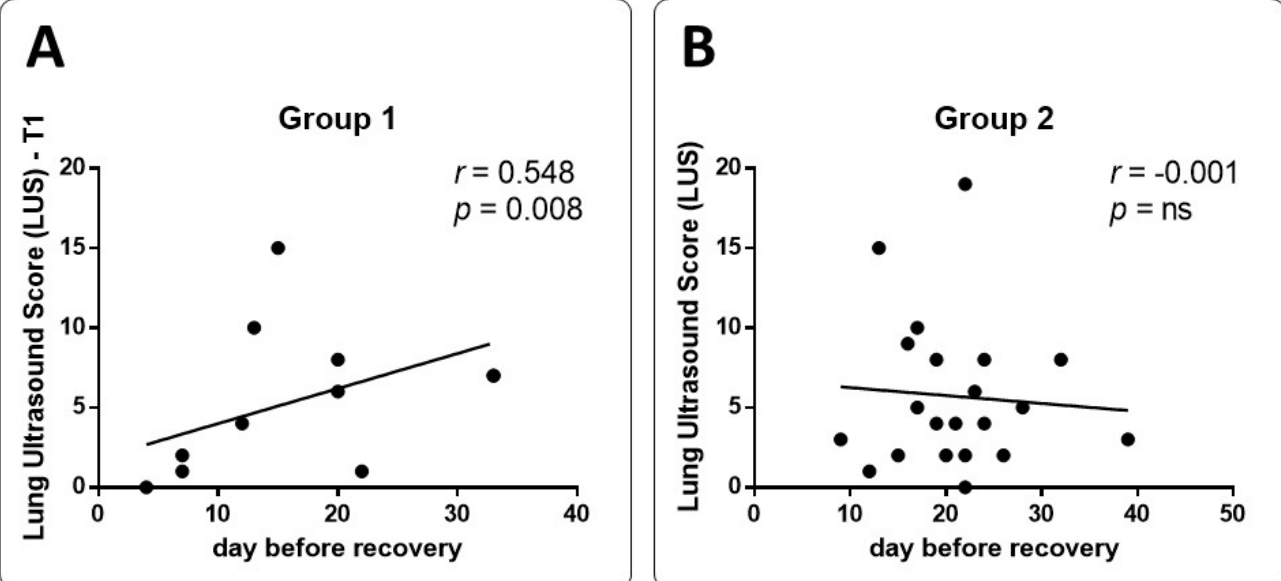
Figure 3. Correlation between the LUS scores evaluated at the follow-up visit and the days before recovery in patients who underwent mAb treatment and those who did not. Panel A: correlation in Group 1 at T1 time point (follow-up visit). Panel B: correlation in Group 2 at follow-up visit.